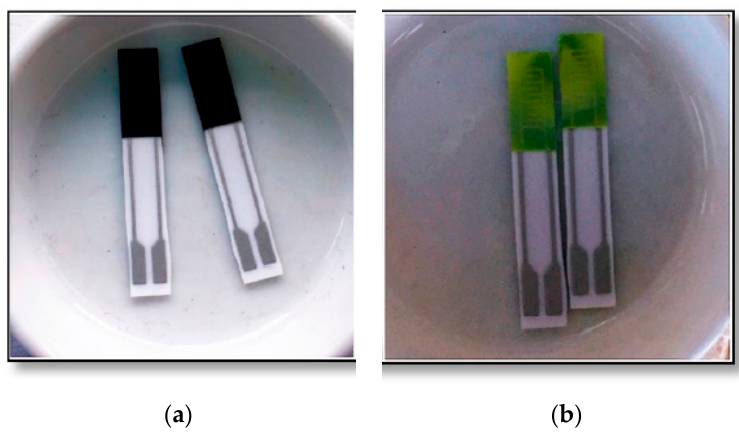
Figure 1. ( a ) Left, WO 3-X layer with impurities; ( b ) Right, WO 3